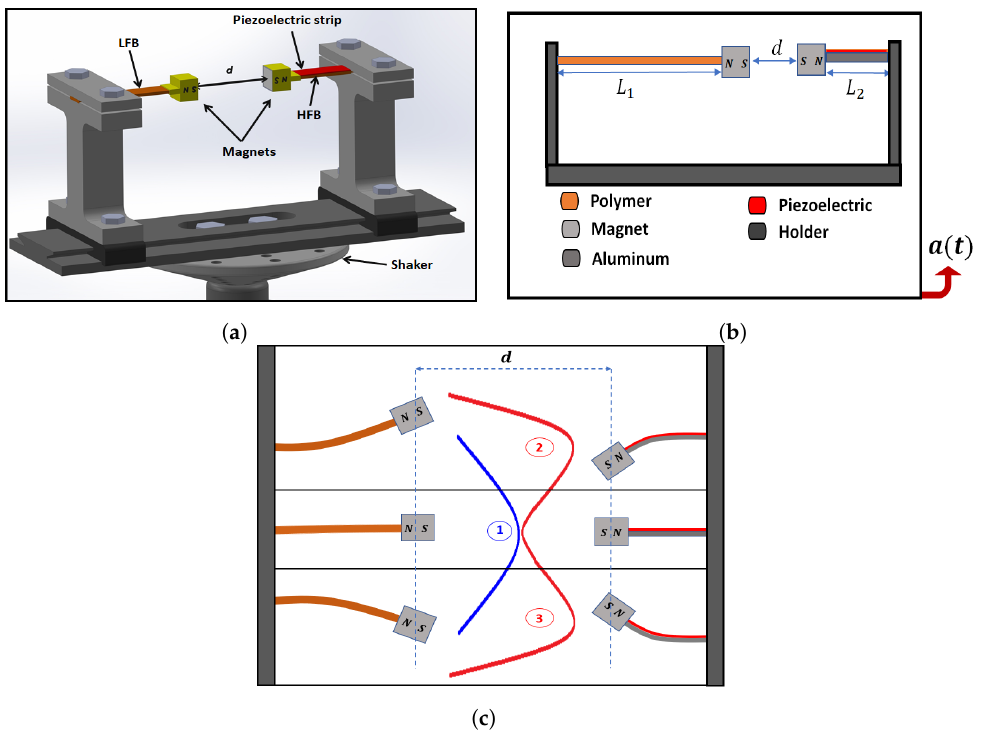
Figure 1. ( a ) A 3D model of the energy harvester system. ( b ) A 2D schematic of the energy harvester system. ( c ) The mono and bistable principles of operation under repulsive magnetic